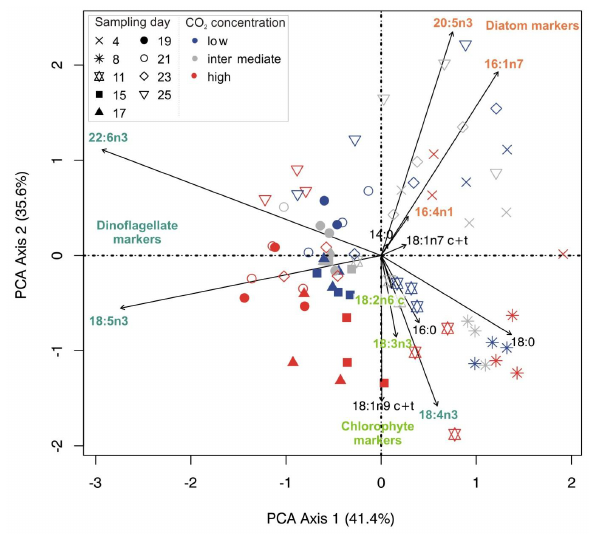
Fig. 4. Biplot of principal component analysis (PCA) based on fatty acid composition in each mesocosm on each sampling day. Individ- ual samples are colour coded according to p CO 2 level as in Fig. 1. Symbols refer to sampling days. The first axis explains 41.4% of the variation, the second axis